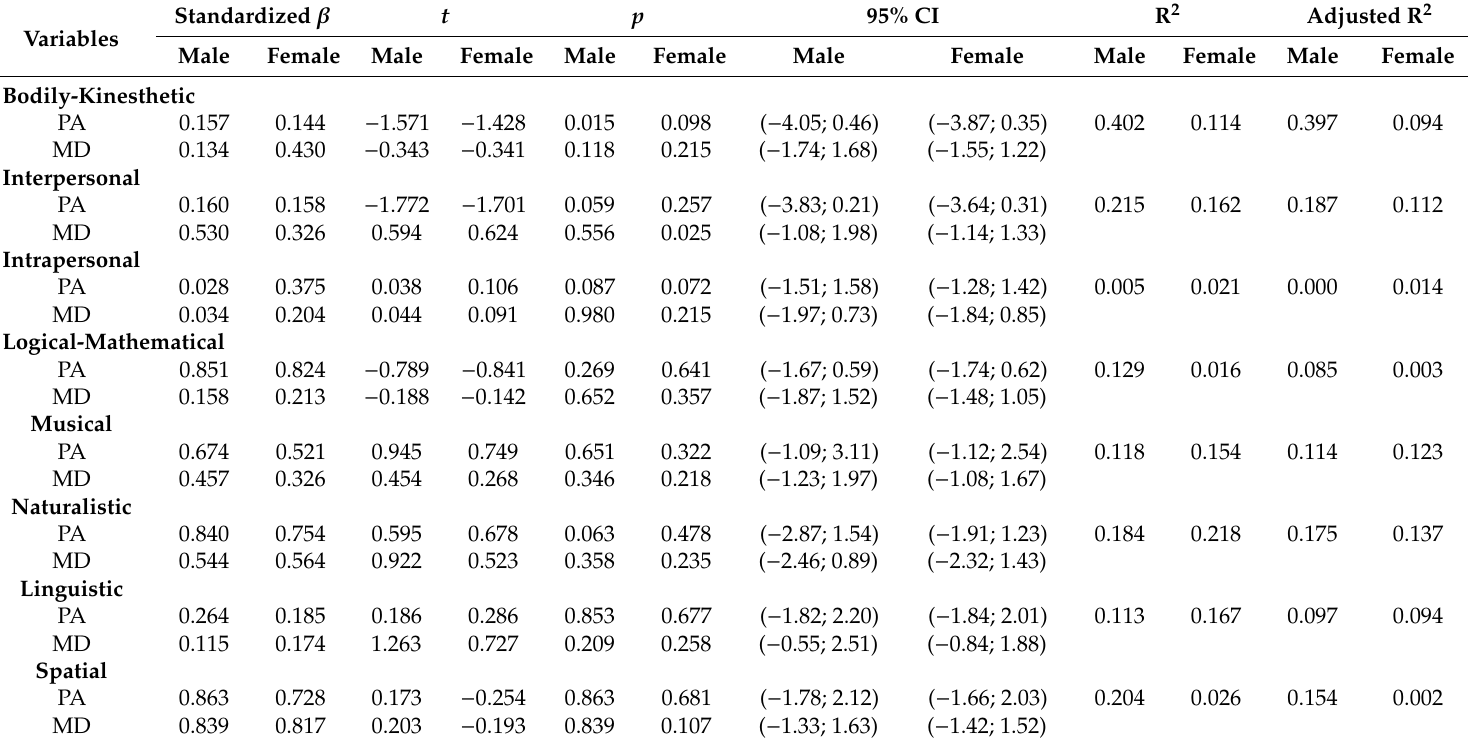
Table 4. Regression model for multiple intelligences, PA, and